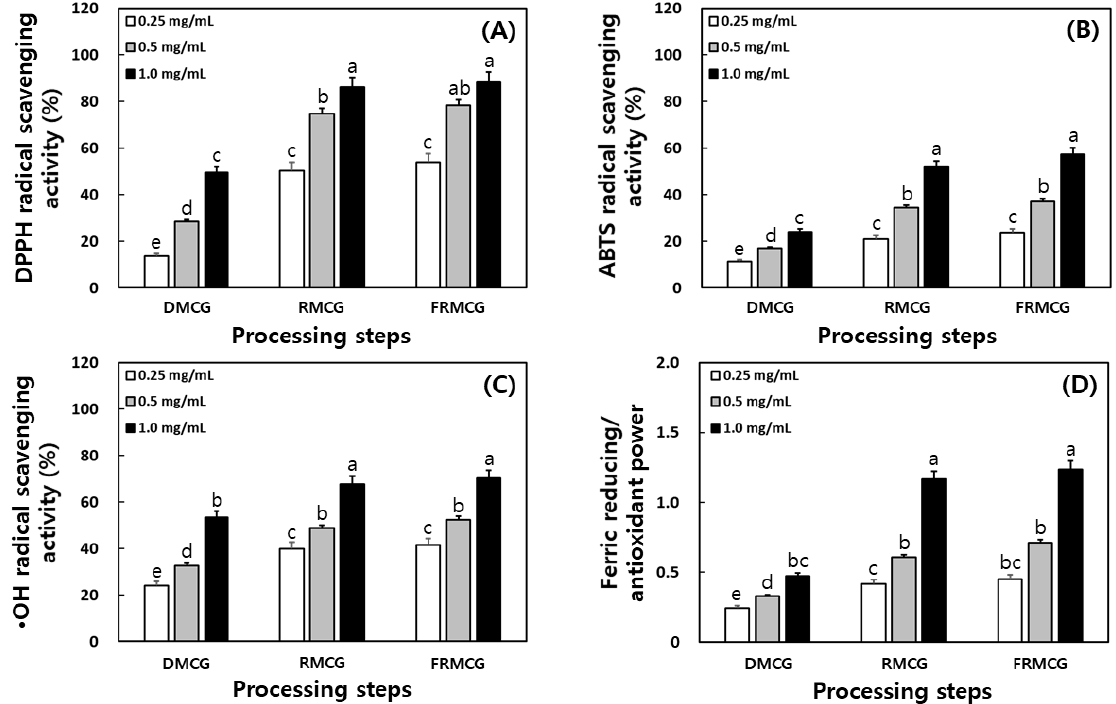
Figure 6. Comparison of antioxidant properties in the 50% ethanol extracts through processing steps of mountain-cultivated ginseng sprouts. ( A ) DPPH radical scavenging activity; ( B ) ABTS radical scavenging activity; ( C ) hydroxyl radical scavenging activity; and ( D ) ferric reducing/antioxidant power. All values are present as the mean ± SD of pentaplicate determination. Different letters correspond to the significant differences relating to the processing steps using Tukey’s multiple test ( p < 0.05). DMCG, dry mountain-cultivated ginseng; RMCG, red mountain-cultivated ginseng; and FRMCG, fermented red mountain-cultivated ginseng.